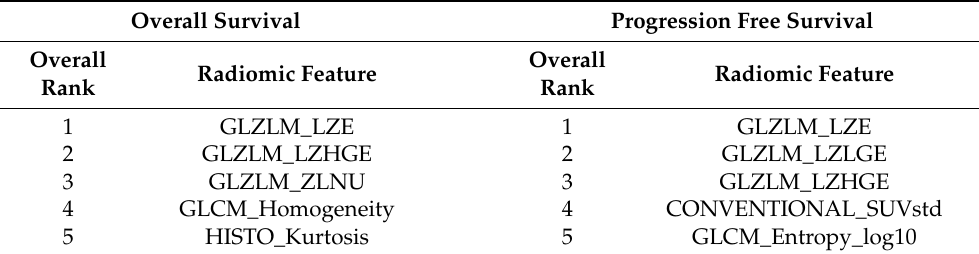
Table 1. Ranking of the selected radiomic features extracted from the 18F-FDG PET, according to association with survival at one